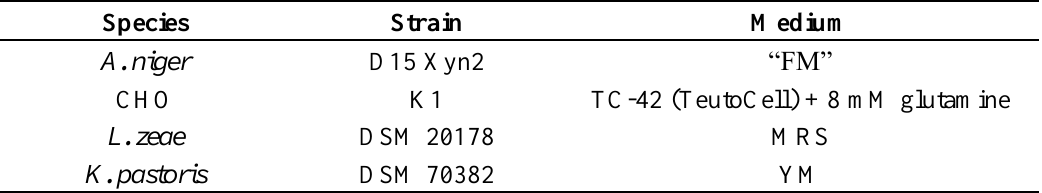
Table 1. Microorganisms and media used for sensor evaluation.